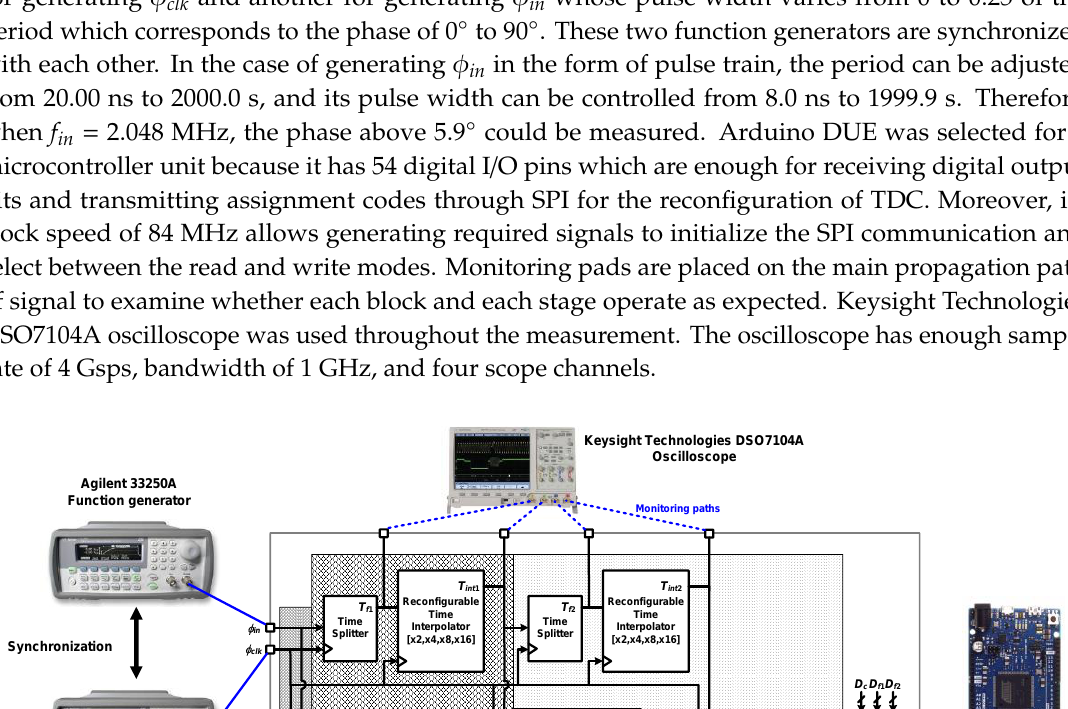
Figure 9. Chip photograph and layout.